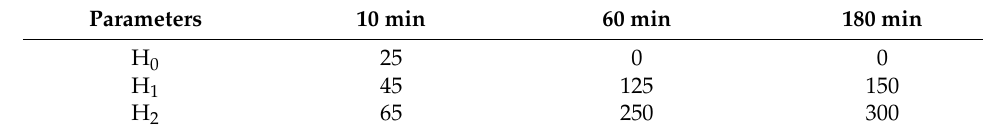
Table 3. Height parameters of legend in Figure 11.